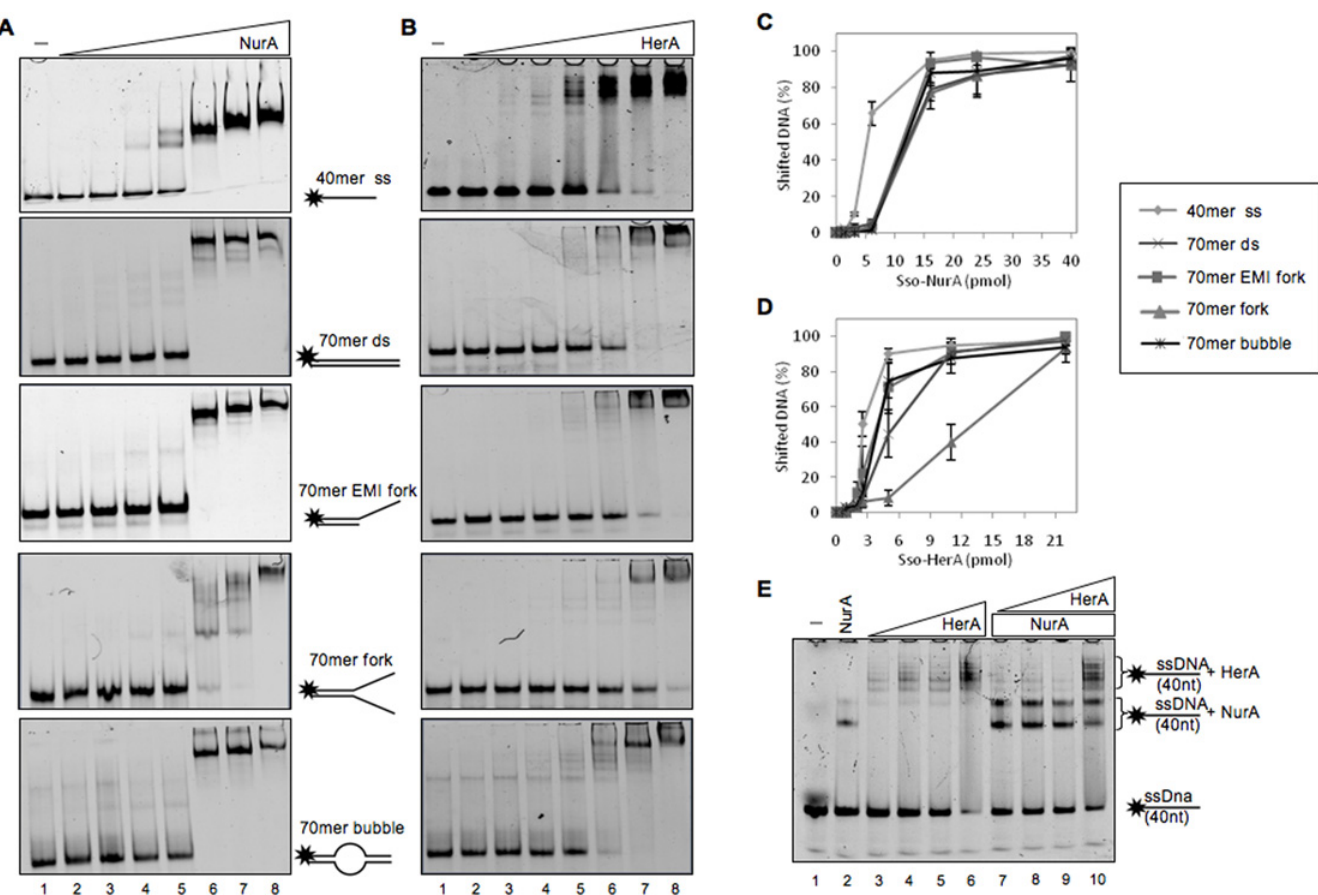
Fig 5. NurA and HerA binding to different DNA structures. Increasing amounts of NurA (A) or HerA (B) have been analyzed for their DNA binding affinity for different DNA structures as described in Material and Methods (single-stranded ODN2, double-stranded, emi-forked, forked and bubble from top to bottom). Substrates with no protein were run on lane 1. The gels have been quantified (as reported in Material and Methods) and the values have been reported on a graph (C and D). The values obtained are the average of three different experiments. (E) HerA promotes NurA DNA binding. DNA binding affinity of NurA/HerA complex on a single-stranded DNA has been analyzed using a fixed amount of NurA (3 pmoles) and increasing amounts of HerA (from 2 to 6 pmoles) separately (lanes 3 – 6) or together (lanes 7 –